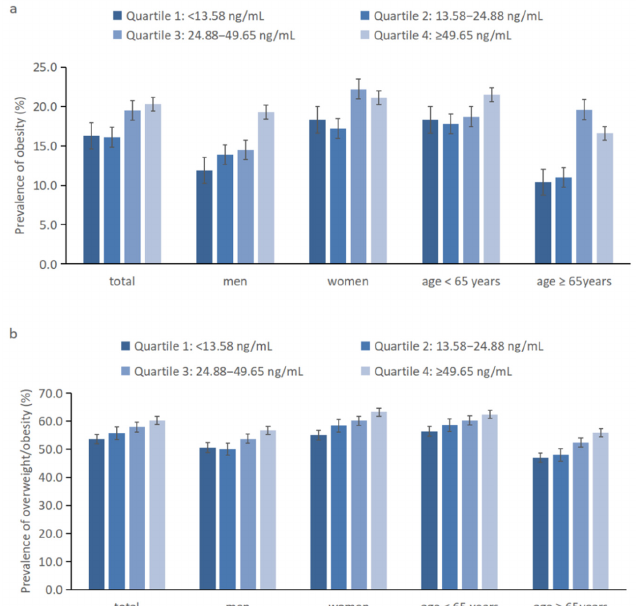
Figure 2. ( a ) Prevalence of obesity (BMI ≥ 28 kg/m 2 ) at different serum spermidine levels in the general population and subgroups by sex and age. ( b ) Prevalence of overweight/obesity (BMI ≥ 24 kg/m 2 ) at different serum spermidine levels in the general population and subgroups by sex and age.